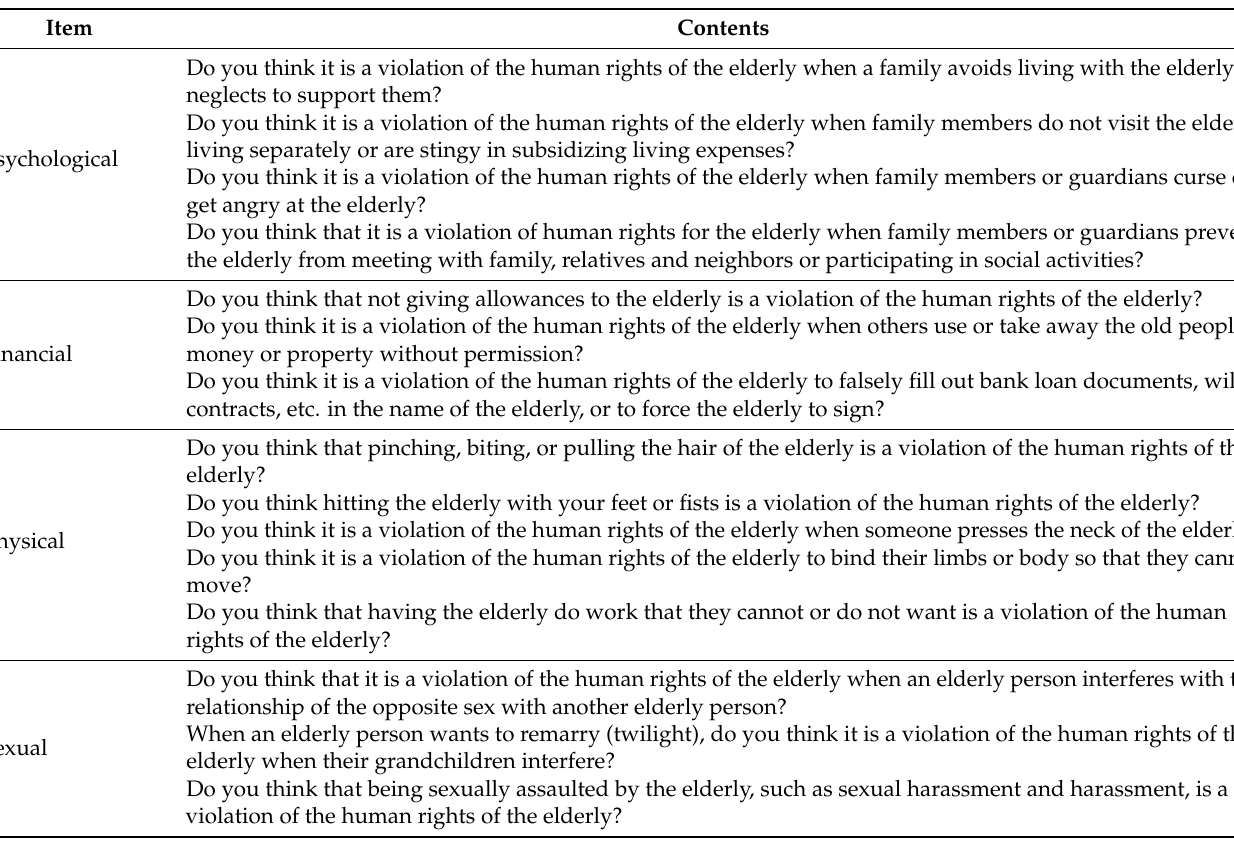
Table 1. Contents of 6 sub-factors for the perception of human rights violations in the